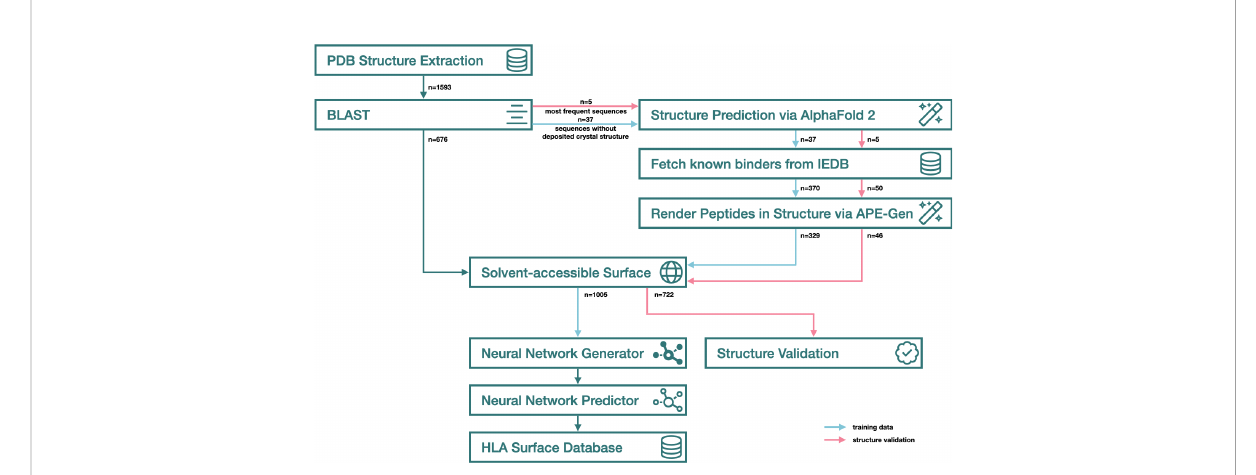
FIGURE 3 Snow fl ake surface accessibility prediction pipeline. Blue arrows represent training data, pink arrows represent validation data, green arrows represent data fl ow identical in both